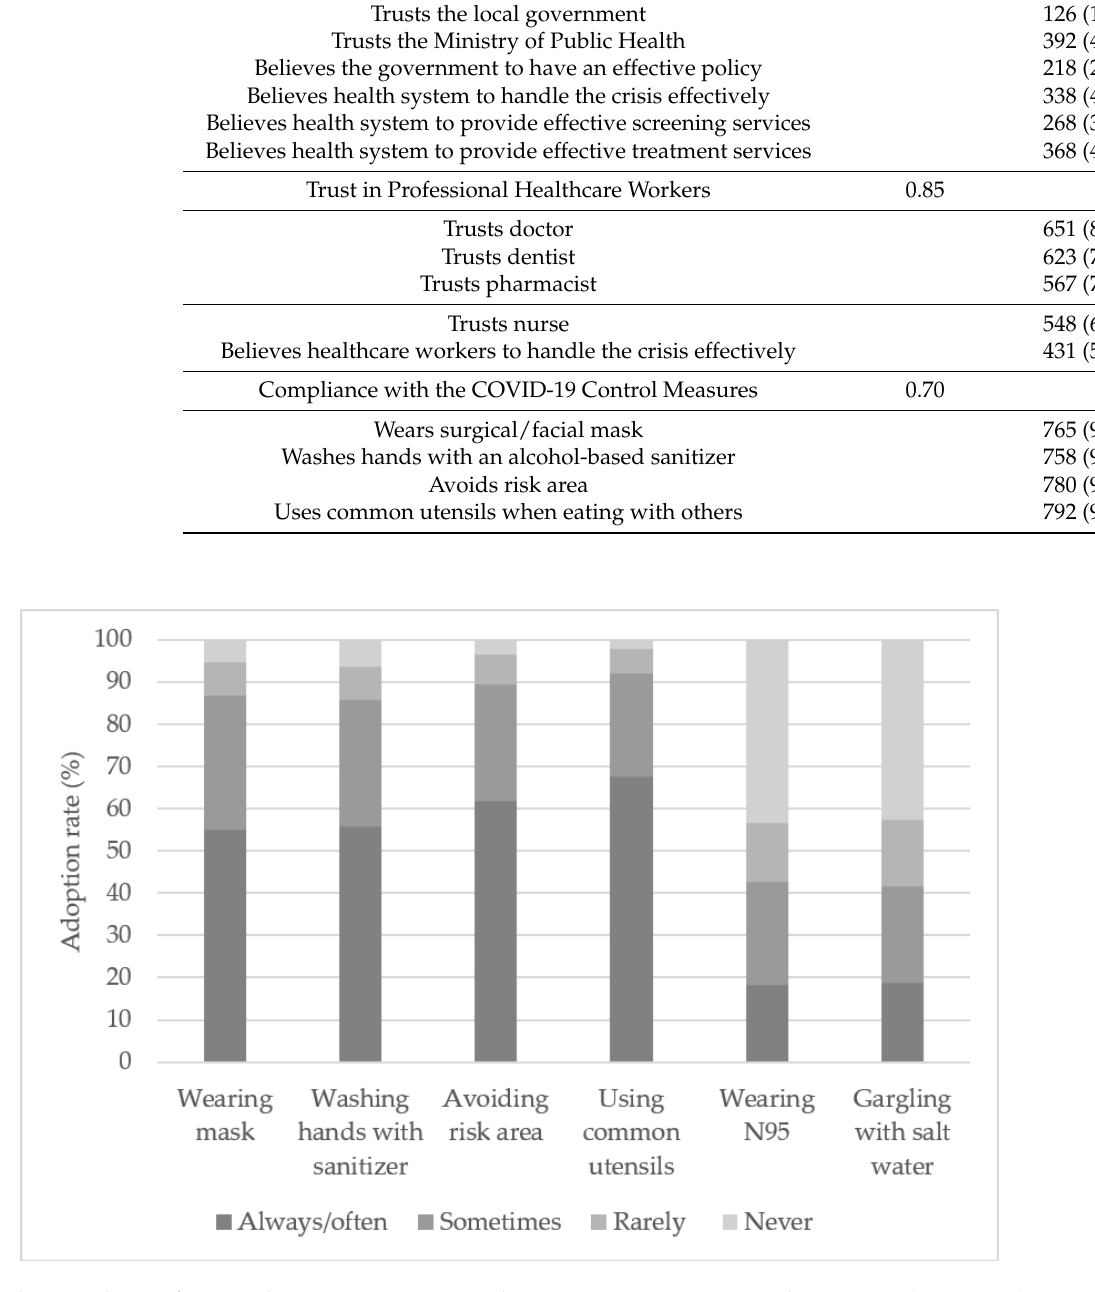
Table 3. Descriptive statistics and Pearson correlation matrix.